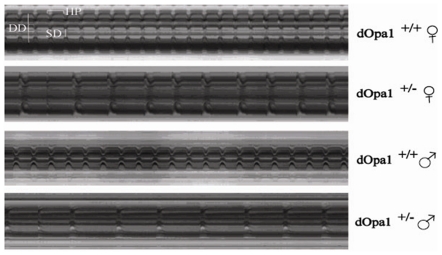
Representative M-mode traces (10 s) of semi-intact Drosophila from different genotype and sex.M-modes were created by electronically “cutting” out a single specified vertical row of pixels that span the heart tube from every frame of the movie, and aligning them horizontally. The M-modes describe the vertical movement of the heart walls in time. In these representative M-modes of 3-week-old dOpa1+/+ and dOpa1+/− Drosophila, it is seen that mutation causes increased heart period, due primarily to increased diastolic intervals. The dilation of mutant heart tube is also visible.